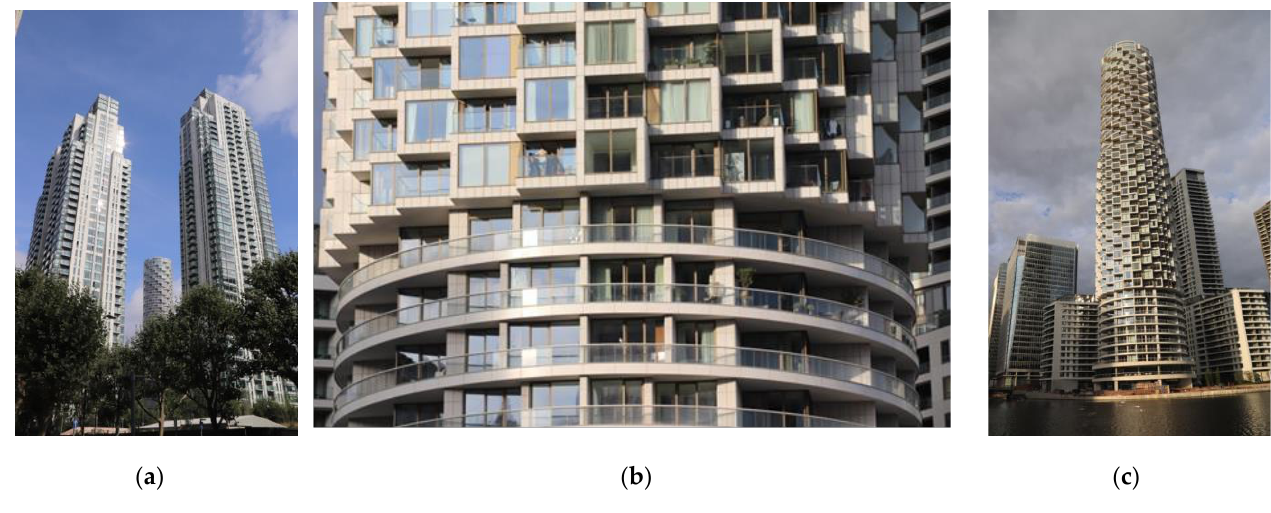
Figure 14. Examples of domestic detailing in residential towers, ( a ) Pan Peninsula; ( b ) Detail of One Park Drive detailing between the base and the middle section (2021); ( c ) Silhouette of One Park Drive with horizontal hierarchy of textures.